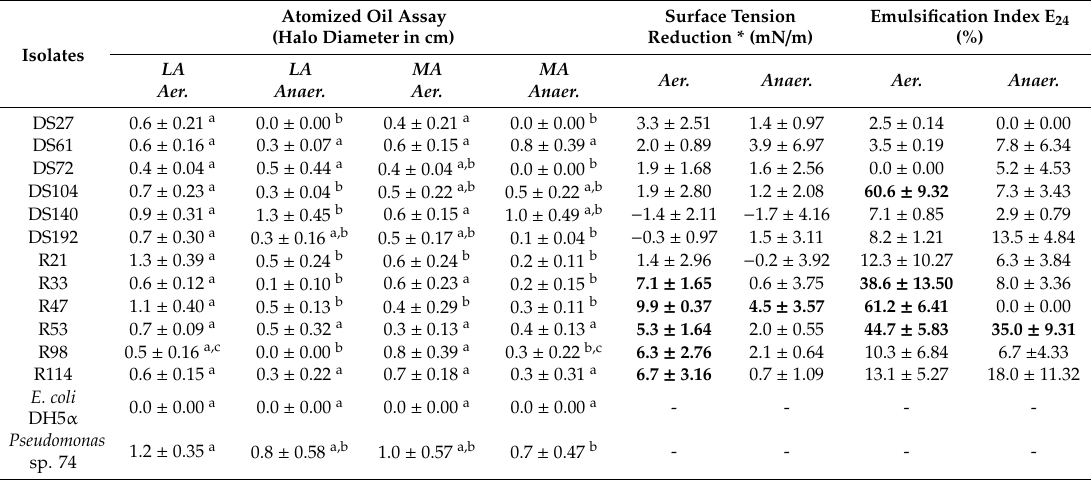
Pseudomonas sp. 74 * Surface tension reduction values correspond to the di ff erence between a cell-free extract of each culture and the corresponding abiotic control (culture medium). Numbers in bold correspond to statistically significant values compared to abiotic controls ( p < 0.05). Di ff erent letters in superscript indicate significant di ff erences per isolate across the di ff erent media / oxygen conditions ( p < 0.05). LA—Luria Agar; MA—Marine Agarose 2216; Aer.—Aerobic cultures; Anaer.—Anaerobic